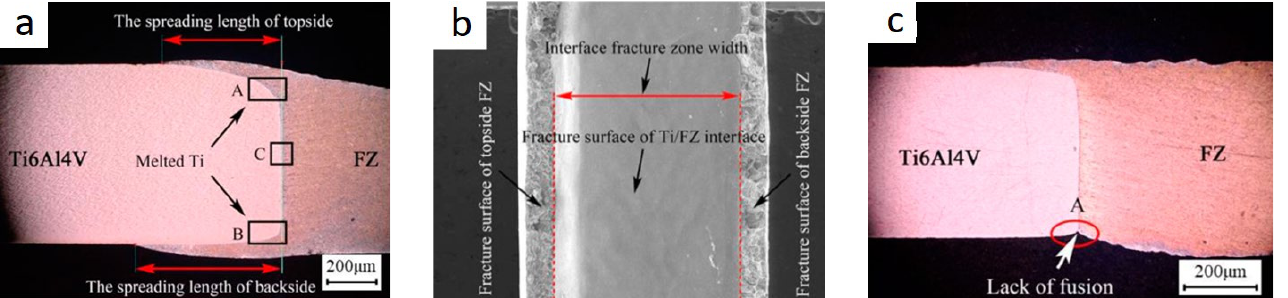
Figure 15. Macrostructure of a welded joint of the Ti and Al: ( a ) joint with a full top and bottom spreading, ( b ) fracture surface of a tensile speciment ( c ) joint with lack of fusion and bottom spreading [27].